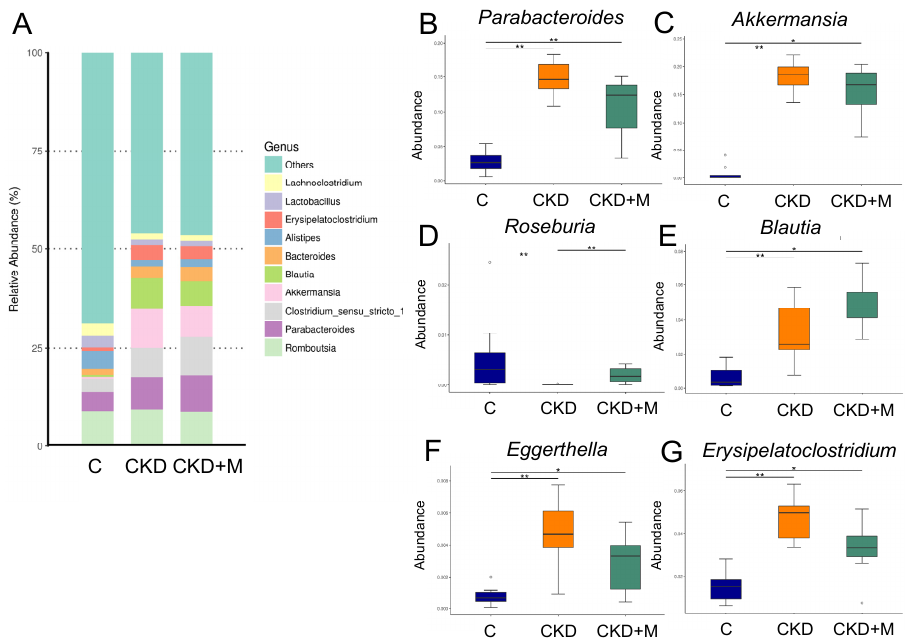
Figure 2. Gut microbiota at the genus level in male rats. ( A ) The relative abundance of the top 10 genera of the gut microbiota among the three groups. The abundance of genera ( B ) Parabacteroides , ( C ) Akkermansia , ( D ) Roseburia , ( E ) Blautia , ( F ) Eggerthella , and ( G ) Erysipelatoclostridium among the three groups. N = 8/group. Data are shown as means ± SD. The single asterisk indicates p < 0.05 vs. C. The double asterisk indicates p < 0.01 vs. C.